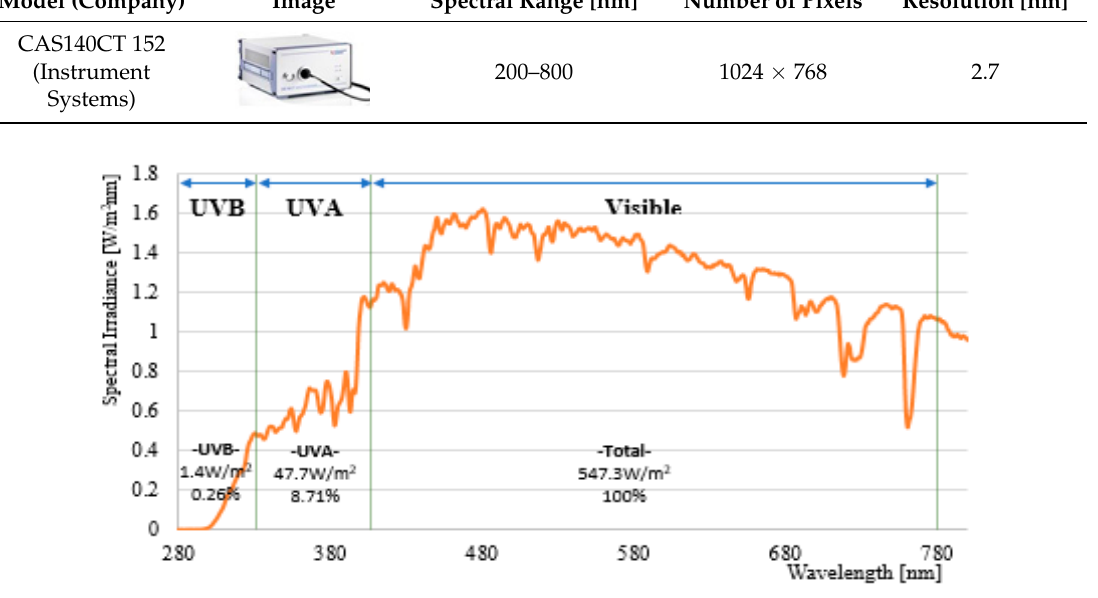
Figure 1. Characteristics of sunlight by wavelength.